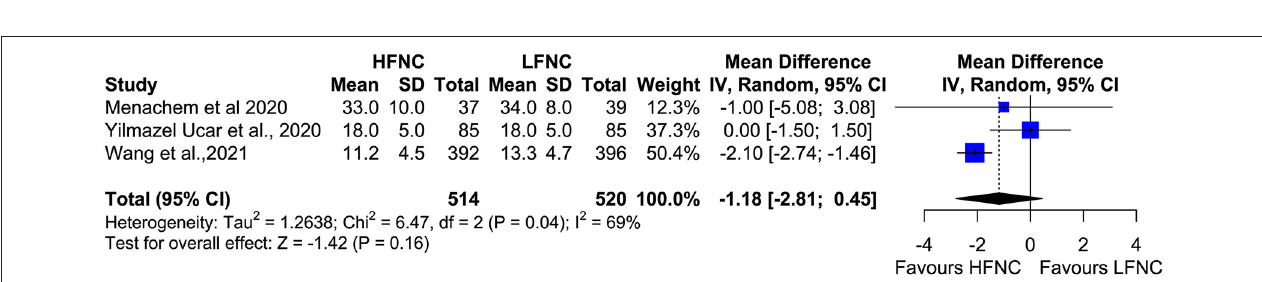
FIGURE 6 | Meta-analysis of the duration of hypoxemia in patients receiving HFNC compared to LFNC in patients undergoing bronchoscopic procedures.